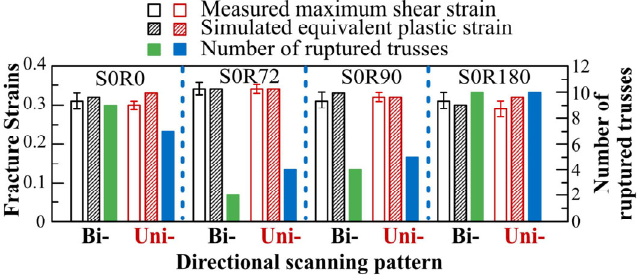
Figure 21. Comparison of fracture strains from experiments and simulations. For clarity, the total number of ruptured trusses have also been added for each case.